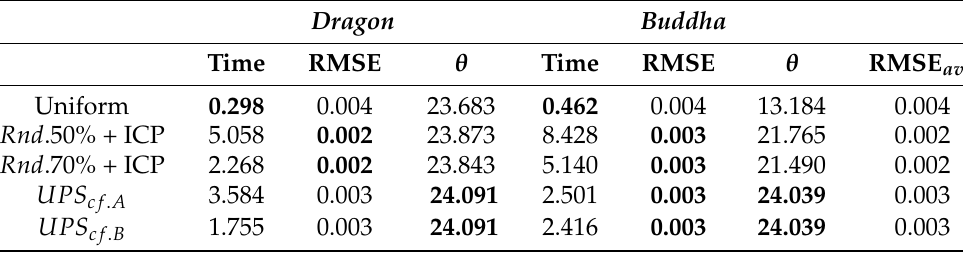
Table 6. Effect of downsampling in the registration. View elapsed time (in seconds) and RMSE (in